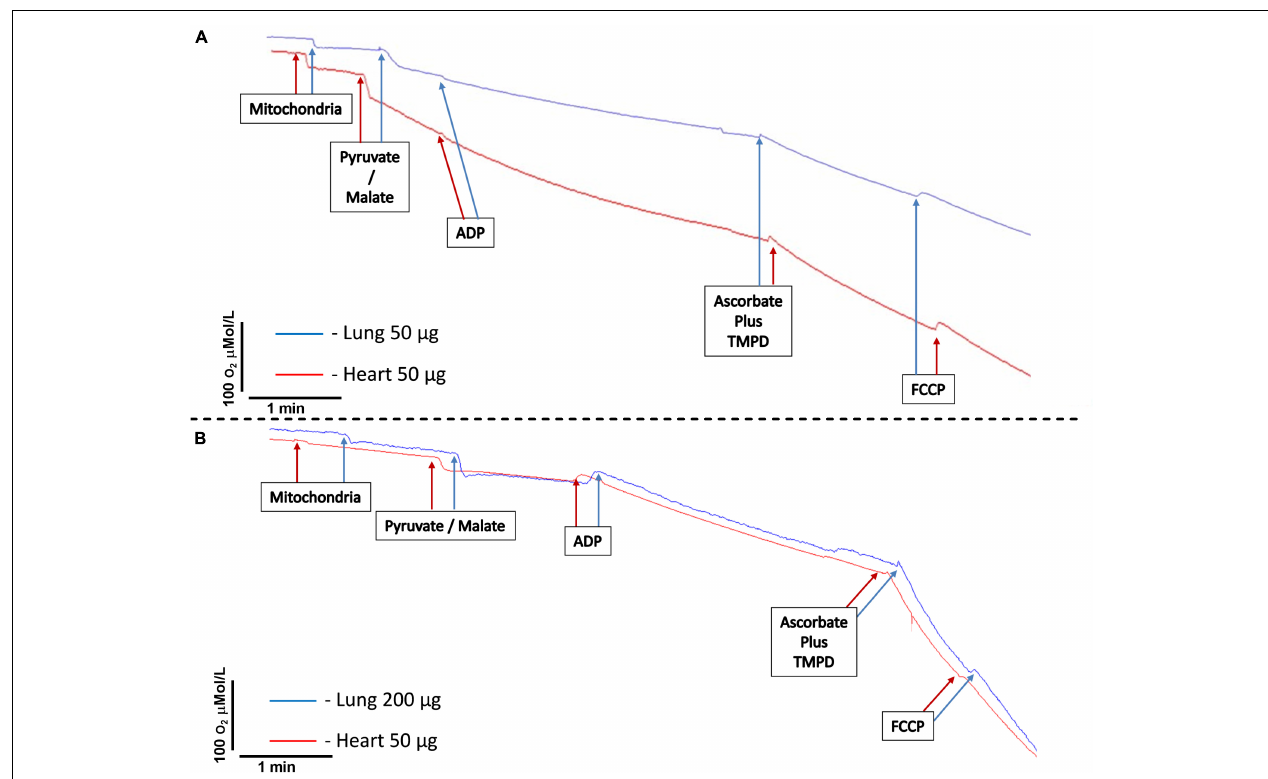
FIGURE 2 | Representative tracings of mitochondria oxygen consumption. (A) Comparison between isolated mitochondria loading from heart (50 µ g) and lung (50 µ g) tissues. (B) Comparison between isolated mitochondria loading from heart (50 µ g) and lung (200 µ g) tissues. Mitochondria represents the moment of the addition of isolated mitochondria. Pyruvate/malate represents the time of addition of pyruvate 5 µ mol/L/malate 5 µ mol/L. ADP signals the time to add ADP 400 µ mol/L. Ascorbate 3 mmol/L plus N,N,N,N-tetramethyl-p-phenylenediamine dihydrochloride (TMPD) 300 µ mol/L indicates the addition of ascorbate and TMPD. FCCP indicates the addition of carbonyl cyanide 4-(trifluoromethoxy)phenylhydrazone 30